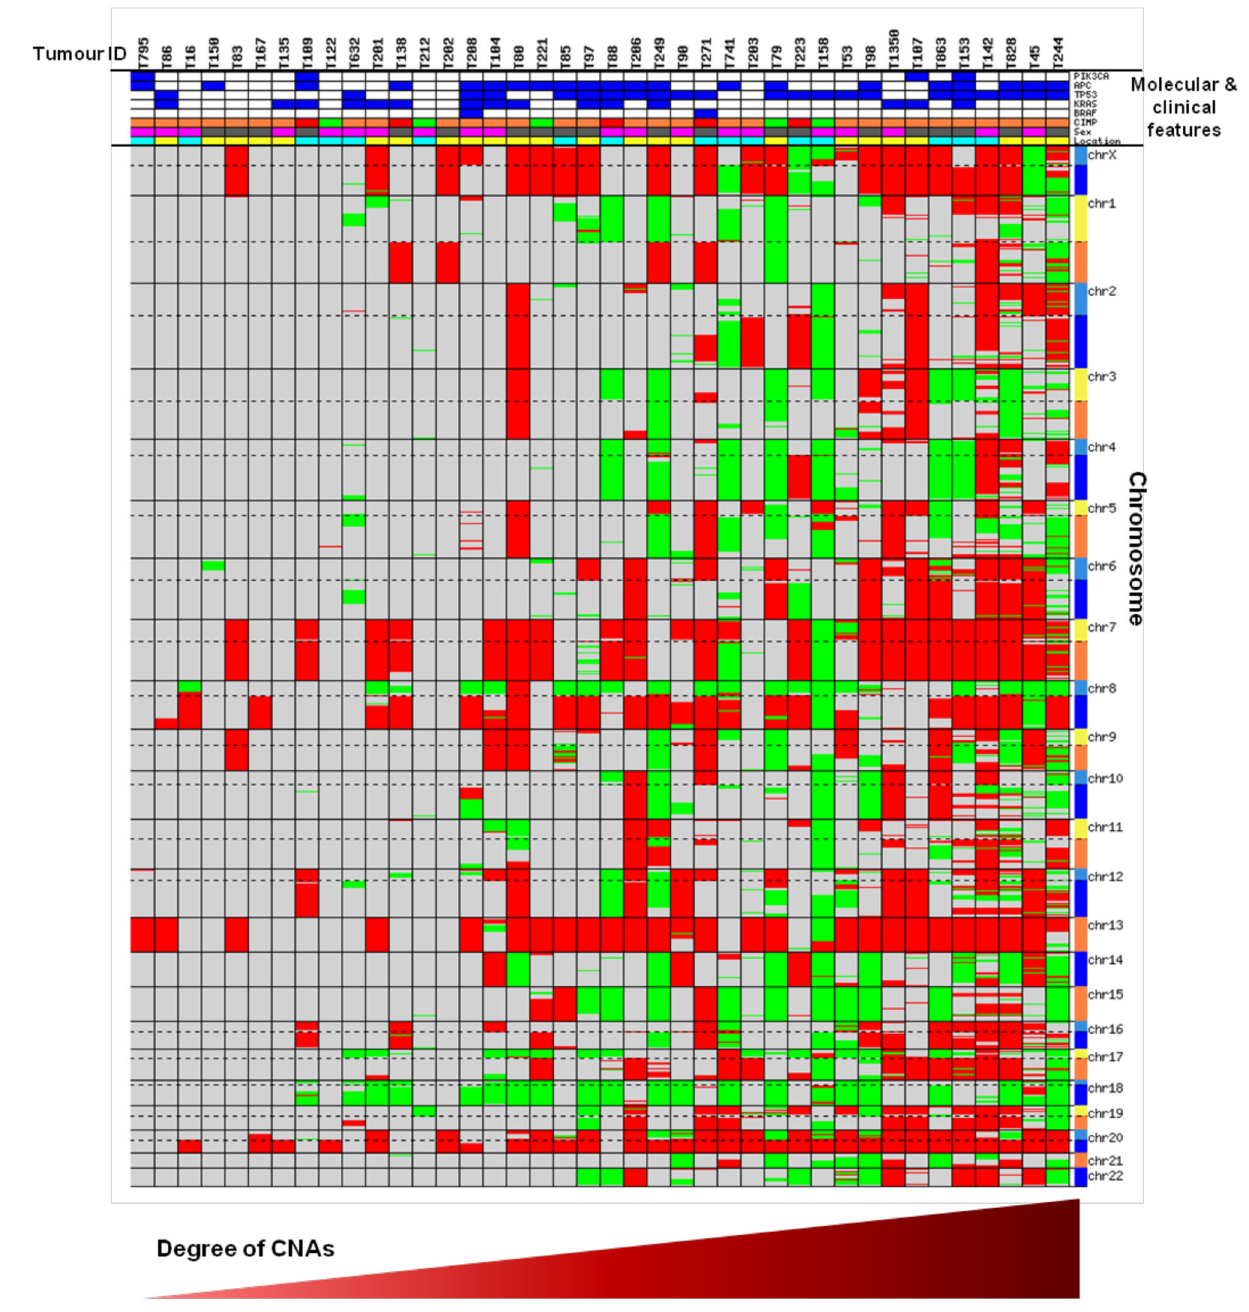
Figure 2. CNA identified in 40 CIN tumour samples (180K format array). Representation of all the CNA identified in 40 chromosomally unstable cases analysed using the 180K platform. Red represents gain and green represents deletion. Dotted lines mark centromeres. Molecular and clinical features in order from top; PIK3CA , APC , TP53, KRAS and BRAF mutation status (blue and white represents mutant and WT respectively), CIMP (red, orange and green represent CIMP-H, CIMP-L and CIMP-N respectively), patient’s gender (pink and grey represent female and male respectively) and tumour location (yellow and cyan represent proximal and distal respectively).